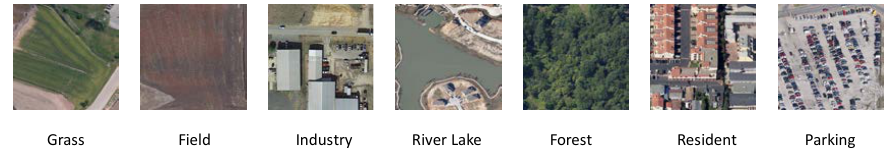
Figure 5. Example images of the